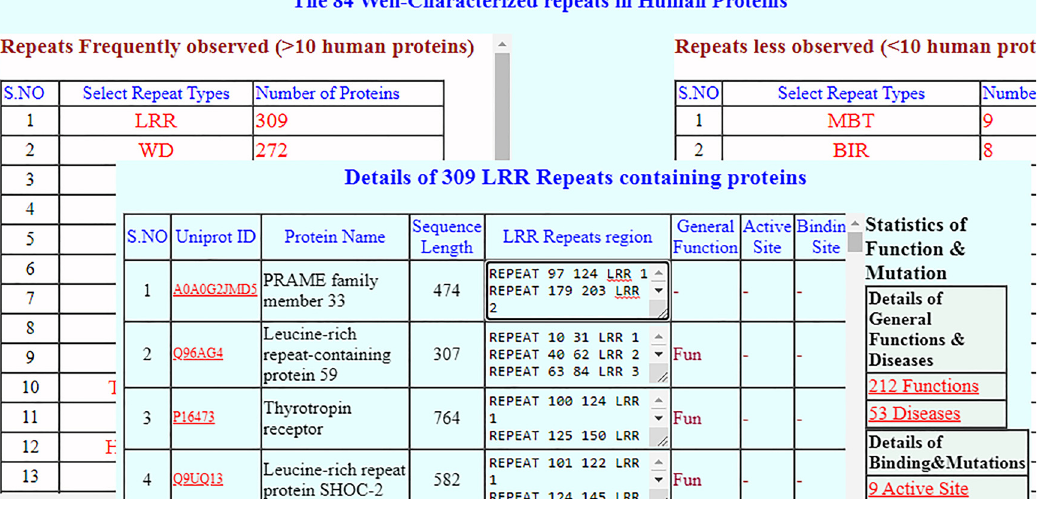
Figure 3: The different well-characterizedrepeats of humanproteinsand the details of LRR repeat containing proteinsfunctions, mutations and